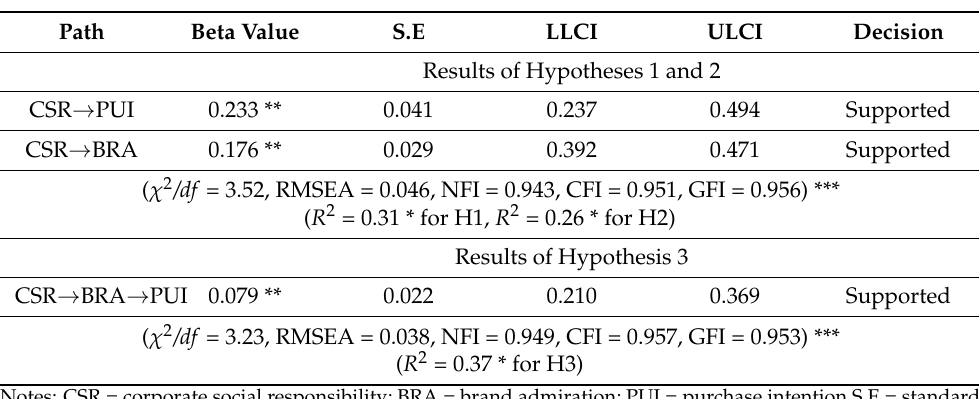
Table 3. Hypotheses